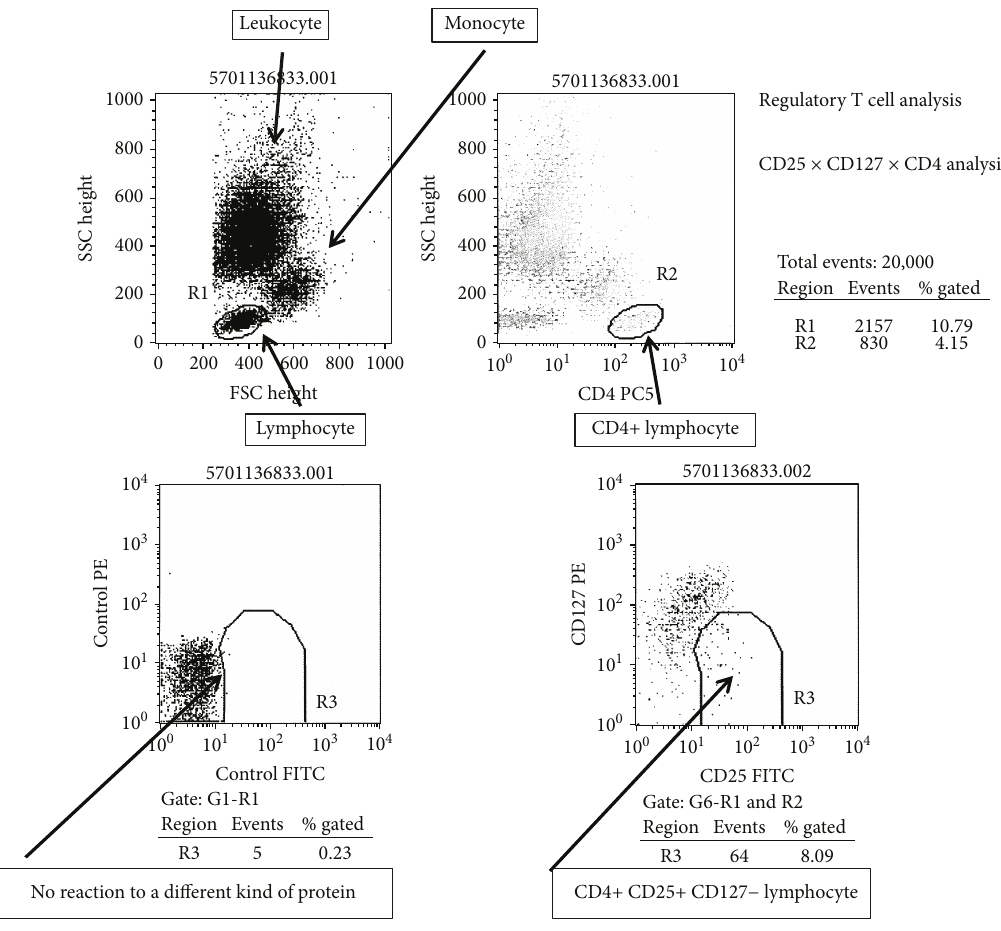
Figure 3: Flow cytometric detection of CD25 FITC and CD127 PE in CD4-positive T cells. Upper left: leukocytes, monocytes, and lymphocytes; upper right: CD4-positive lymphocytes; lower left: no detection of a di ff erent protein (control); lower right: CD4-positive/ CD127-negative lymphocytes (Treg). Table 1: Clinical characteristics for 23